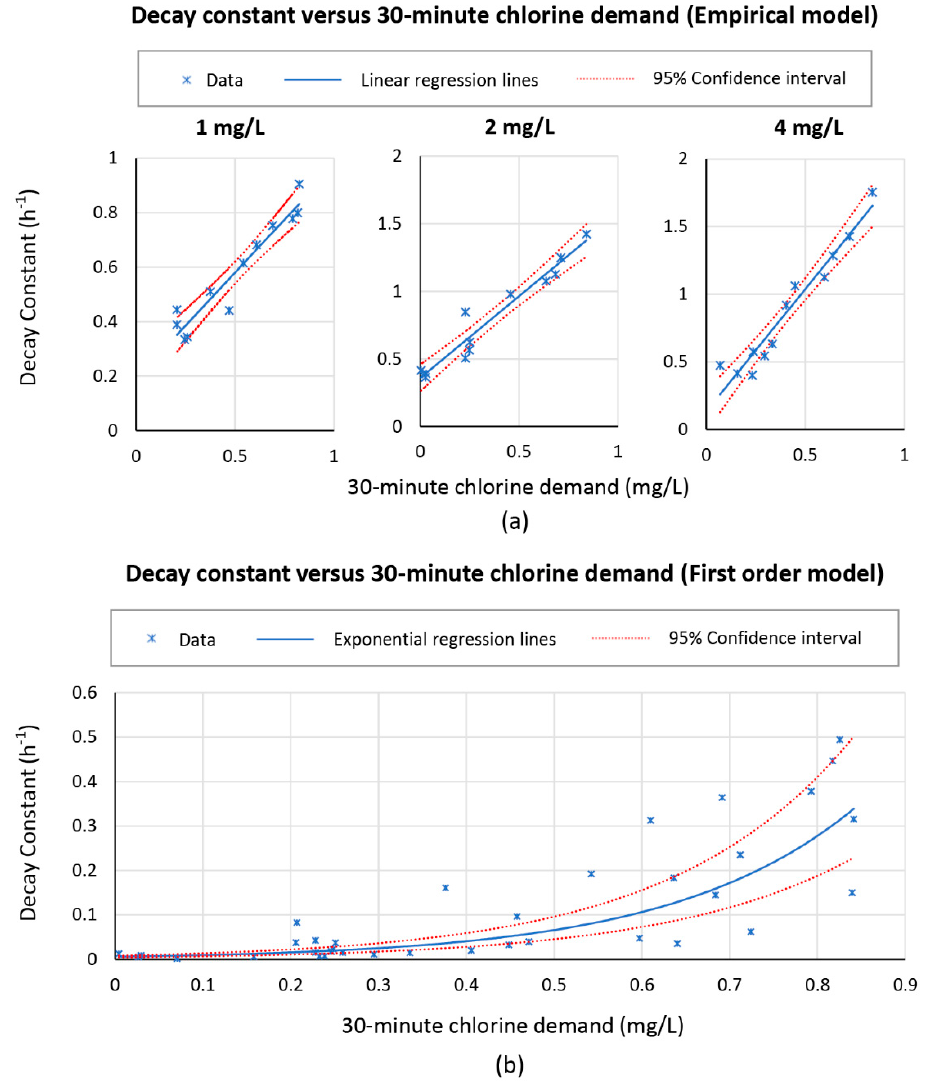
Figure 7. Mathematical relationship between decay constant and 30-min chlorine demand of test water. Figure ( a ) is for decay constant in Feben and Taras’s empirical model. Figure ( b ) is for decay constant in first order model.